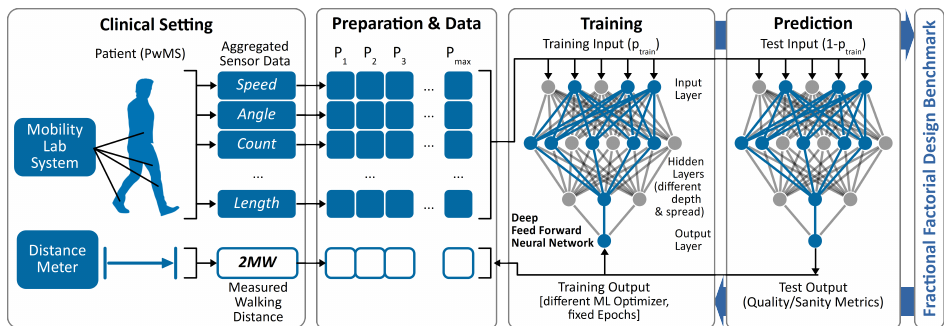
Figure 1. Minimal viable ML-based approach for 2MWT prediction. After aggregating MLS data and manually measured walking distances from PwMS, the data are transposed to a table-based (columns P 1..max : patients; rows: speed, ..., 2MW: features and learning objective), thus ML-compatible representation, prepared, split and fed into a DFFNN based on TensorFlow. The model training bases on incrementally improved configurations (FFDB) to optimize the prediction quality, expressed by predefined metrics. [Abbreviations: ML = Machine Learning; 2MWT = 2 minute Walk Test; MLS = Mobility Lab System; PwMS = People with Multiple Sclerosis; DFFNN = Deep Feed Forward Neural Network; FFDB = Fractional Factorial Design